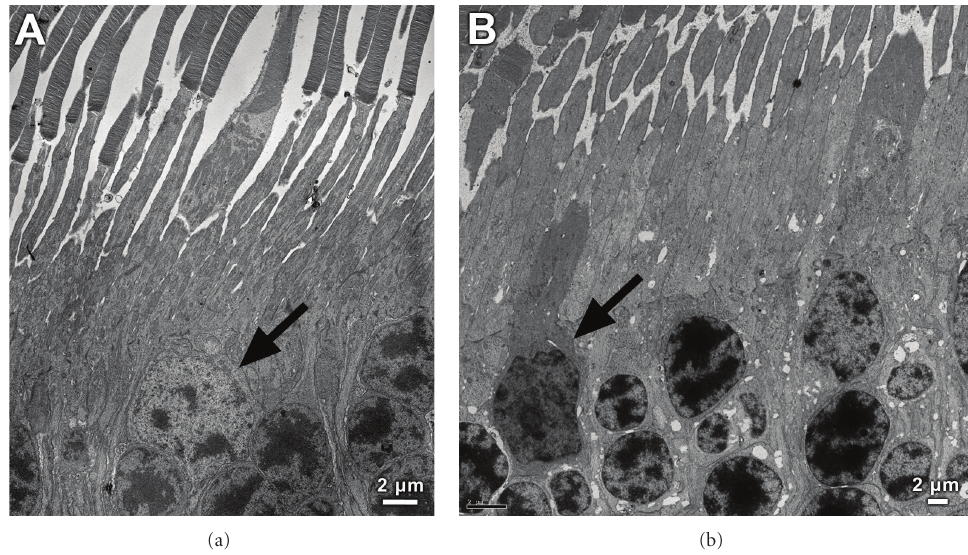
Figure 6: Ultrastructure of the outer retina of a normal 2-year-old dog (a) and that of the a ff ected 3-year-old dog (b). Note the condensed configuration of the cone nuclei in the retina of the a ff ected animal (arrow) in comparison to that of the normal one (in (a), arrow) and the dark appearance of the inner segments in the retina of the a ff ected animal. Bar depicts magnification which is the same for (a) and